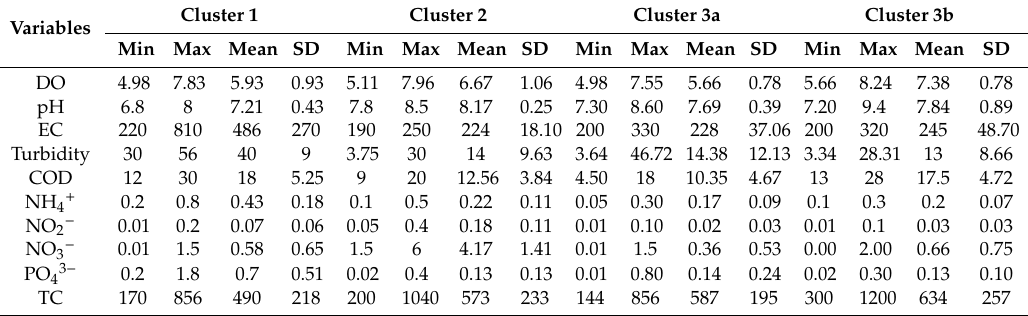
Table A2. Min, Max, Mean and Standard Deviation of water quality parameters at three clusters in the dry season.